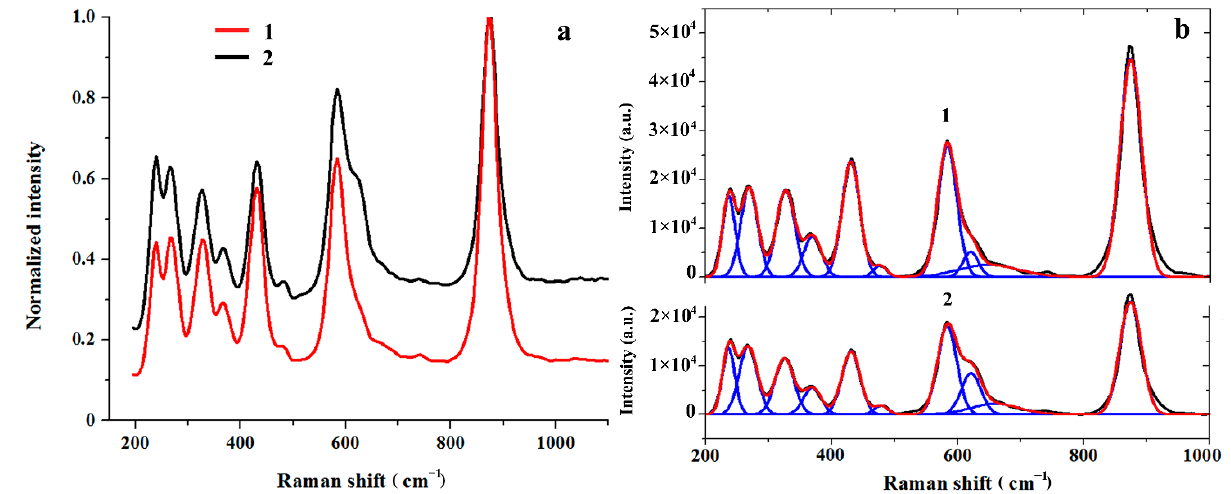
Figure 5. Normalized Raman spectra (1) and their Gaussian expansions (2) of the LiNbO 3 single crystal surface ( z | xx | z scattering geometry): initial ( a ) and modified ( b ) samples. Table 1. Parameters of vibrational bands in the Raman spectra of the initial and modified LiNbO 3 single crystal samples.